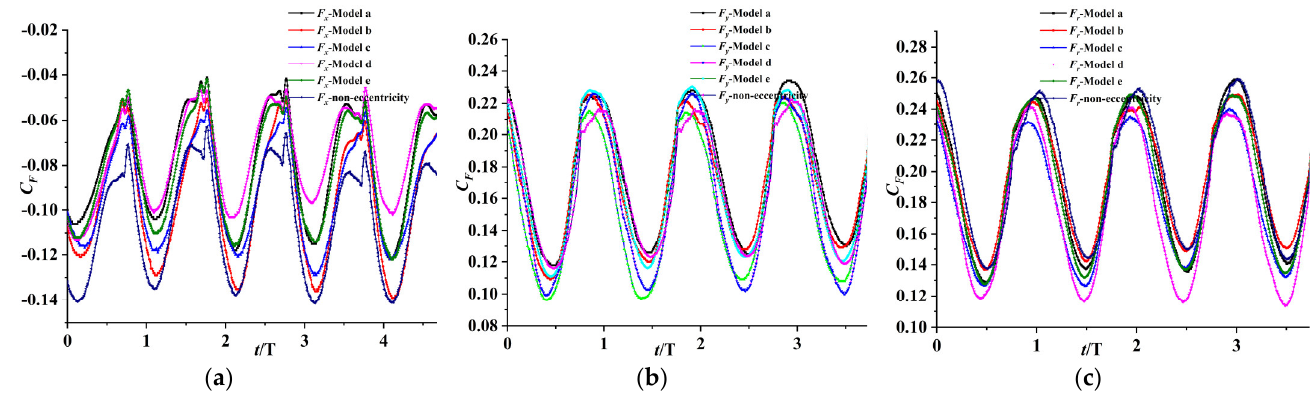
Figure 8. Pressure contours at different moments. ( a ) When the impeller has no eccentricity. ( b ) Model a.